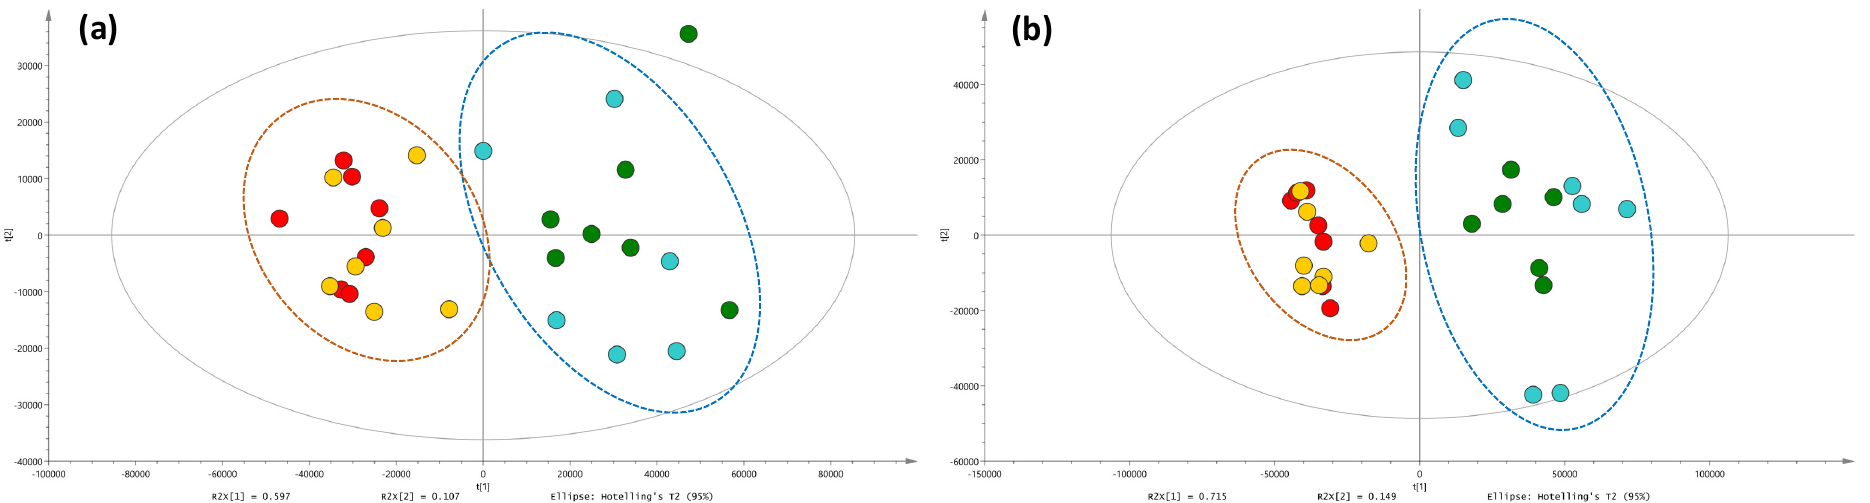
Figure 1. Principal component analysis (PCA)—Comparison of UHPLC-HRMS metabolic profiles from A. officinalis root ( a ) and shoot ( b ) samples associated with R. irregularis , R. intraradices , R. clarus and R. aggregatus , after 9 days of growth in the semi-hydroponic cultivation system. ( R. irregularis MUCL 41833: blue dots; R. intraradices MUCL 49410: green dots; R. clarus MUCL 46238: red dots; R. aggregatus MUCL 49408: yellow dots).